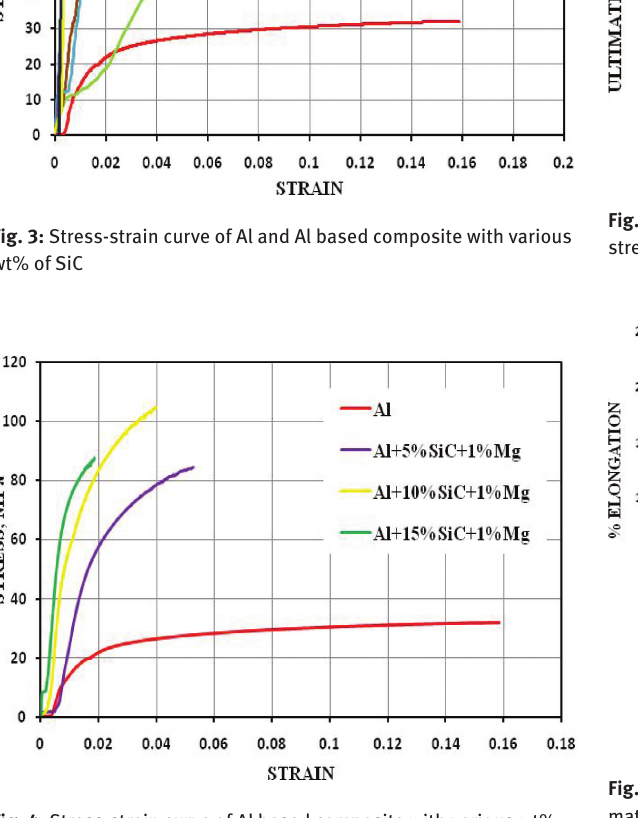
Fig. 4: Stress-strain curve of Al based composite with various wt% of SiC and 1 wt% of Mg